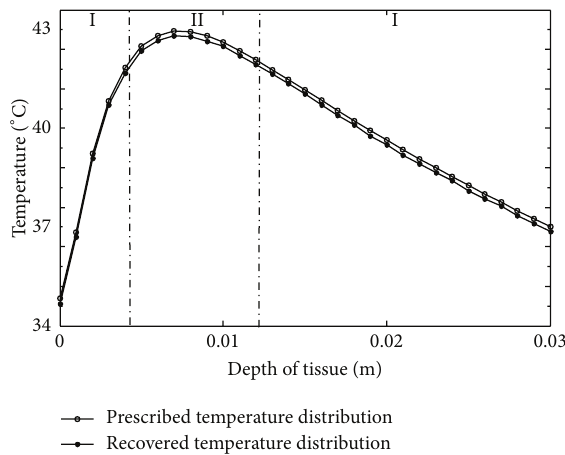
Figure 5: A comparison between recovered and desired tempera- ture distribution at 𝑡 = 1000 s.